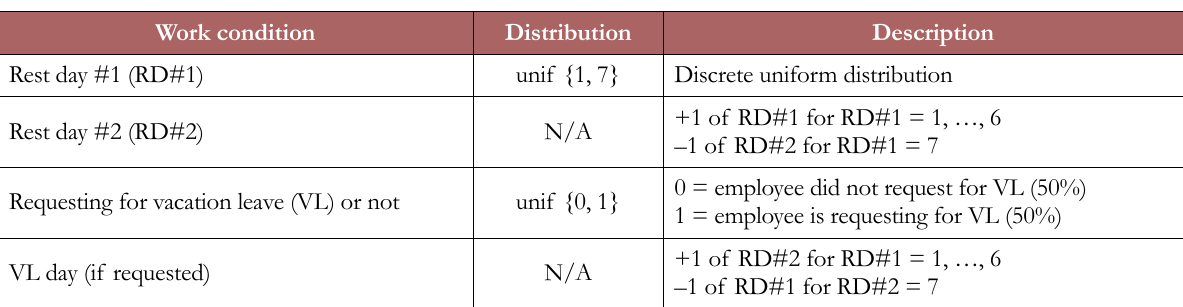
Table 6. Probability distribution and assumptions for rest day and vacation leave